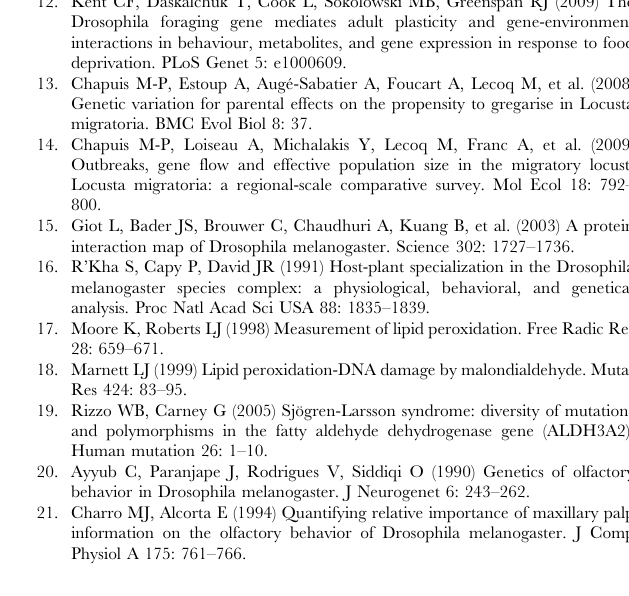
Table S1 Crosses used to generate the homozygous